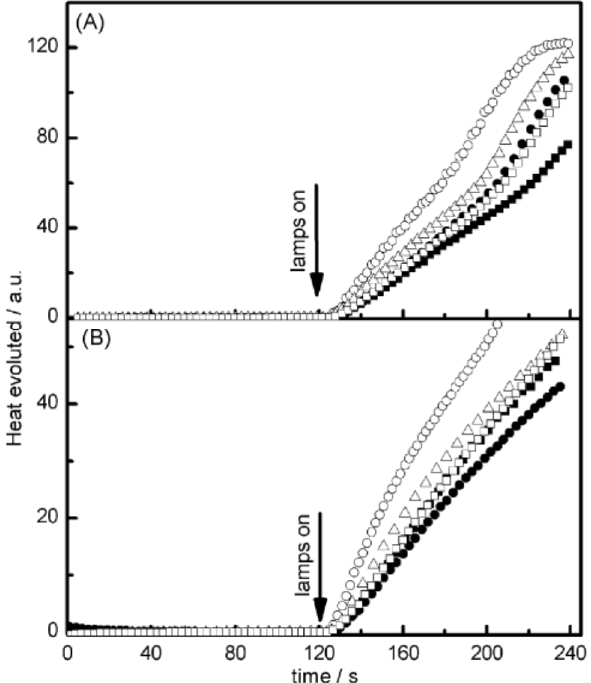
Figure 16. Photopolymerization profiles of TMPTA recorded for QNX-6 ( ▪ ); QNX-7 (O); QNX-8 ( Δ ); QNX-9 (•); QNX-10 ( □ ) and ( A ) Py1 or ( B ) Py2. Reprinted from Ref. [227] Copyright (2008) Elsevier.